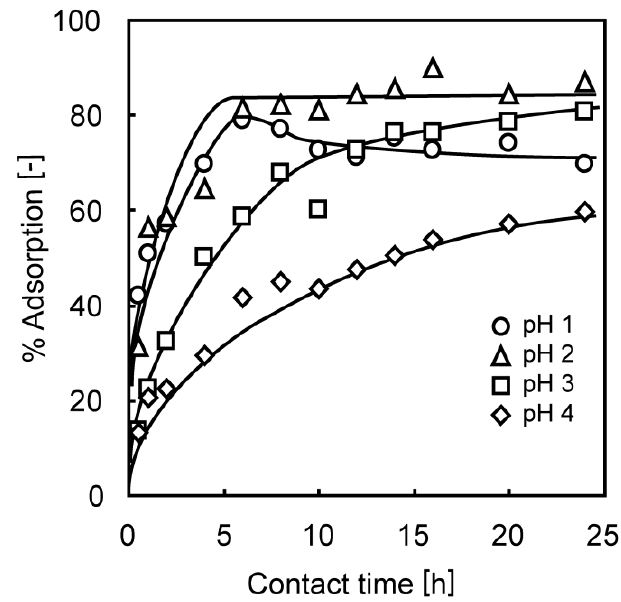
Figure 9. Effect of contact time on the adsorption of total chromium on cross-linked persimmon waste (CPW) gel from chromium(VI) solution at different pH values [23] (with permission for reuse from Elsevier